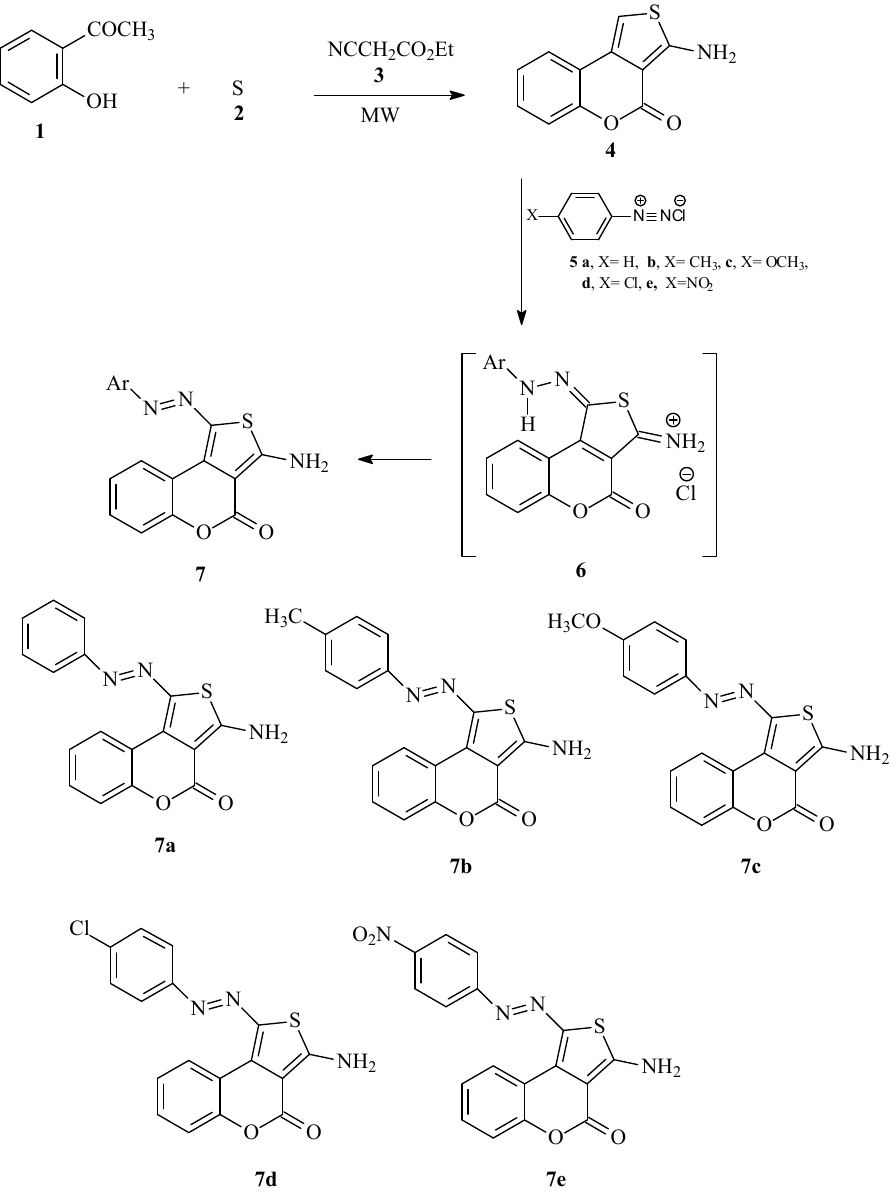
Scheme 1. Preparation of monoazo disperse dyes 7a – e .